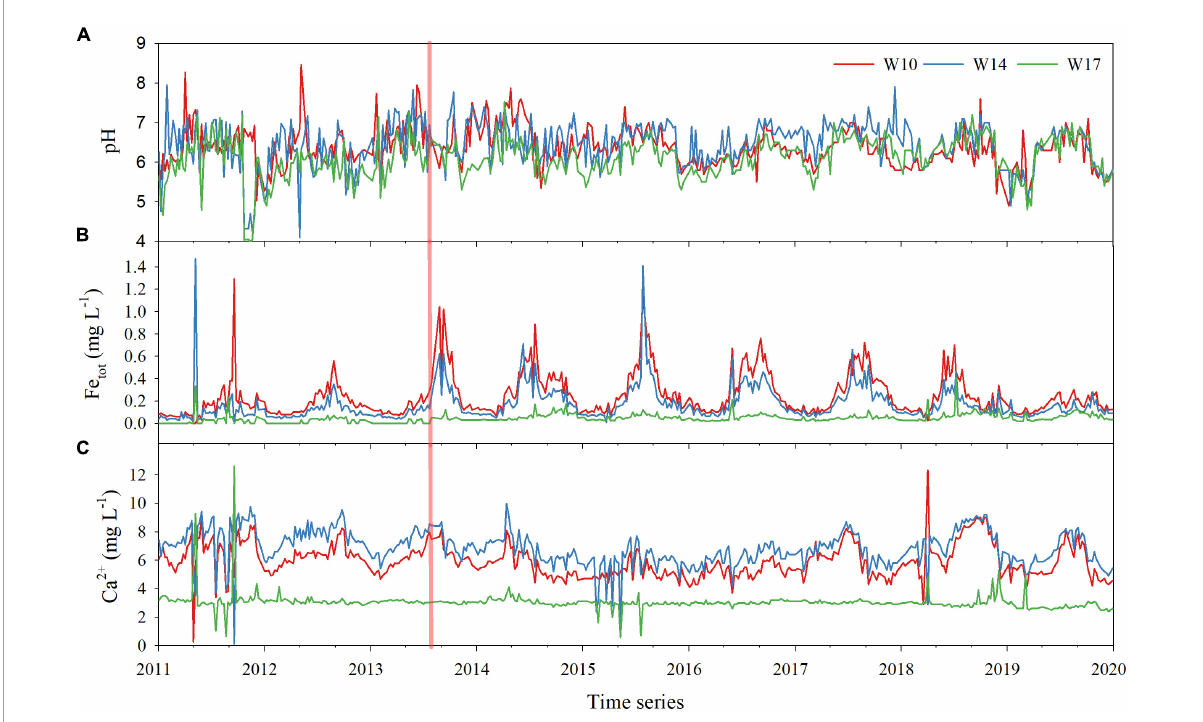
FIGURE3 Time series of pH, (A) total dissolved iron (B) , (Fe tot ), Ca 2 + (C) concentrations at the three Wüstebach catchment stations (W10, W14, W17). The vertical red line indicates the moment deforestation occurred in late summer